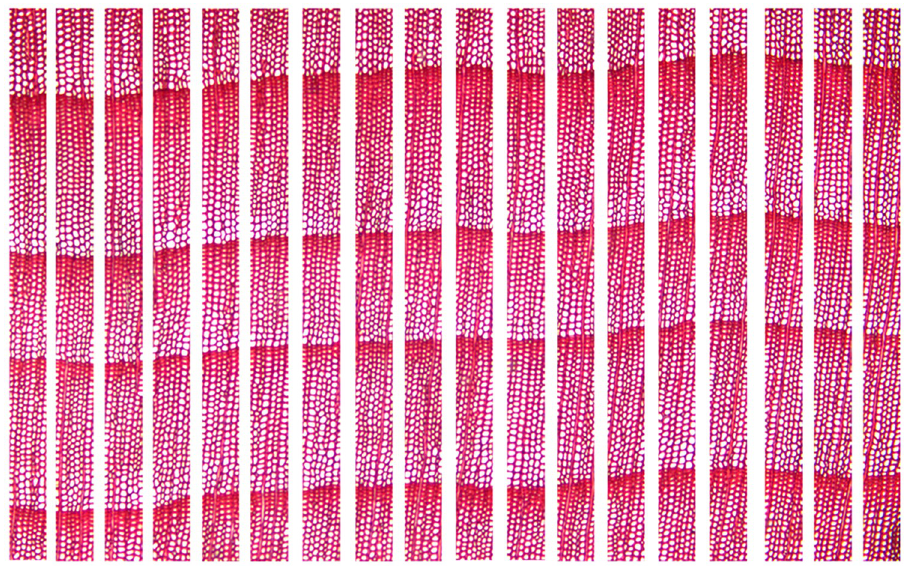
Fig 6. An image set of 20 sub-images after